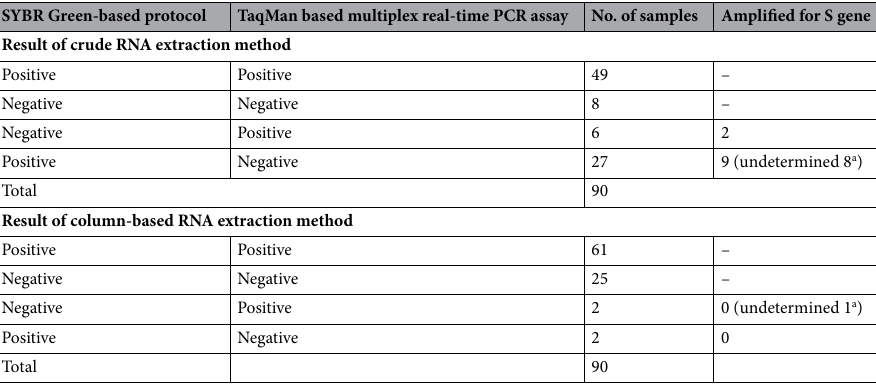
Table 2. Results of samples for crude and column-based RNA extraction methods. a Undertermined results were designated based on spike coding sequence targeted amplification where we could not identify a particular band as positive or negative for the gene.